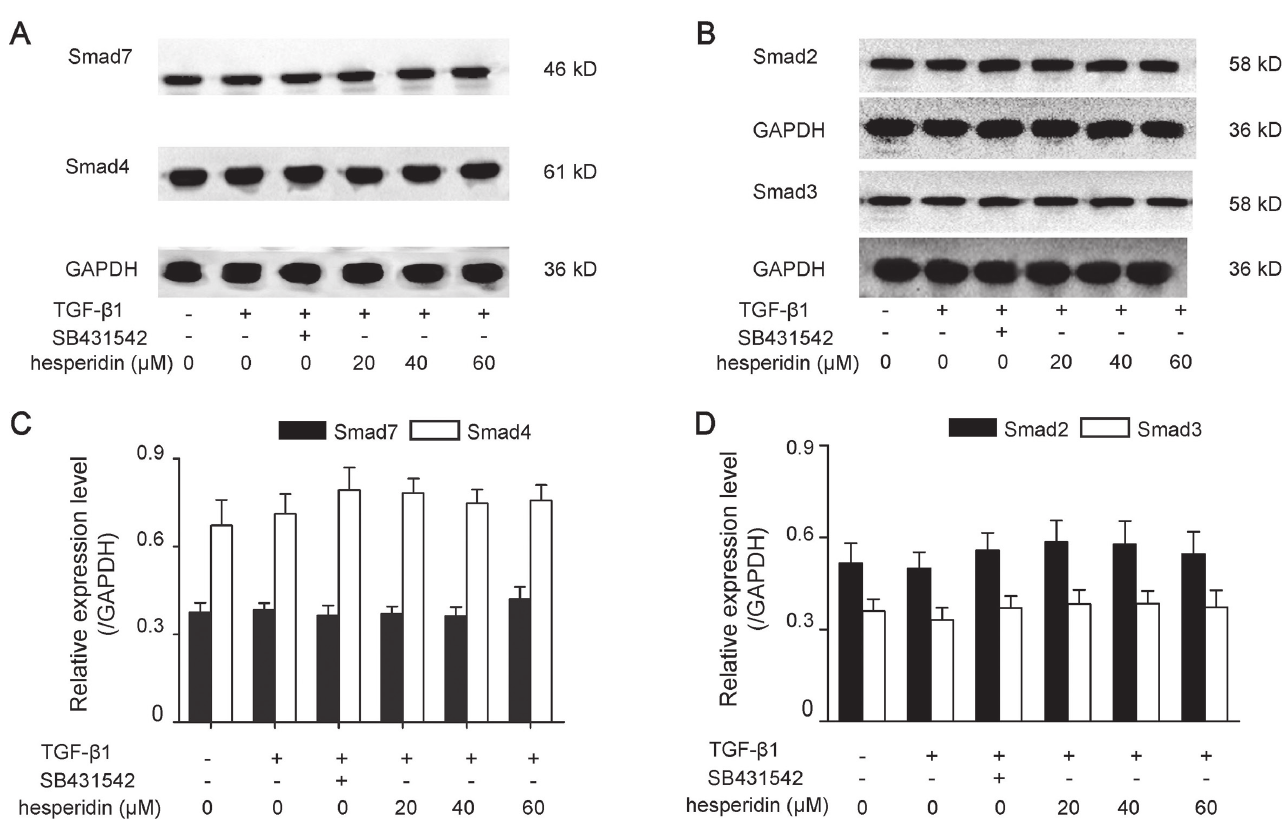
FIGURE 3 - Effect of hesperidin on the synthesis of Smad proteins in the cytoplasm. Lanes 1, 2, 3, 4, 5 and 6 represent the normal control, TGF-β1 control, 10 μM SB431542+ TGF-β1, 20 μM heperidin+ TGF-β1, 40 μM heperidin+TGF-β1 and 60 μM heperidin+TGF-β1 groups, respectively. The GADPH expression was the loading control. The quantitative data, expressing the corresponding Smad protein levels, were assessed using densitometry and are expressed in relative intensity arbitrary units in the panels. The bar represents the standard error of the mean (n =